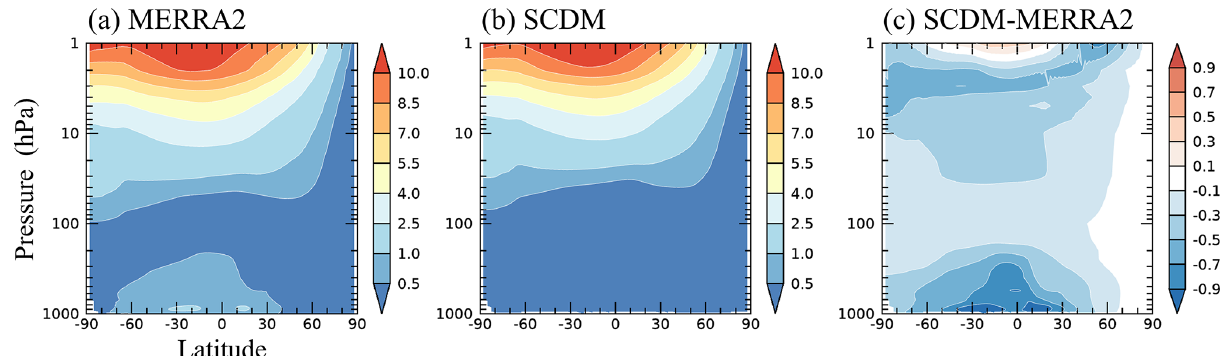
Figure 2. January–March zonal-mean shortwave heating rate (Kd − 1 ) climatology over 1980–2018. Shown are latitude–height cross-sections for (a) MERRA2, (b) SCDM, and (c) the difference between SCDM and MERRA2.